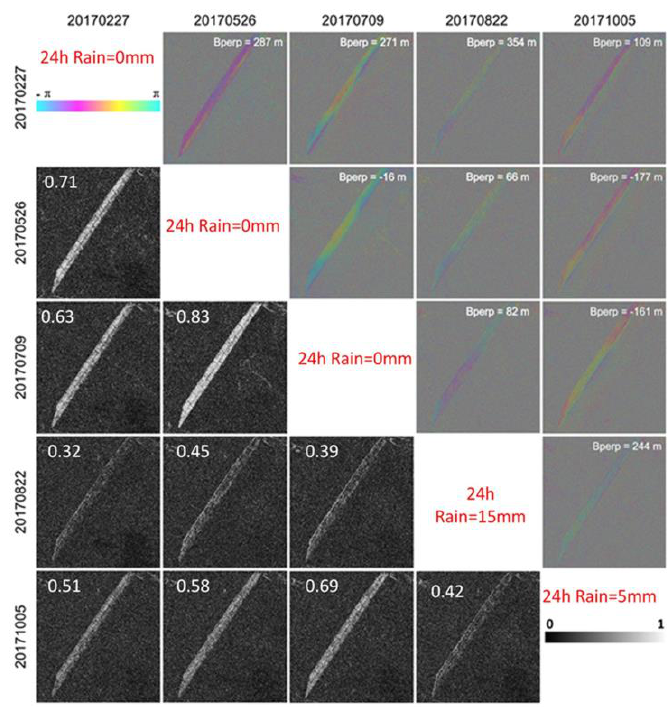
Figure 10. The differential interferograms and coherence map of the ascending TSX-SL